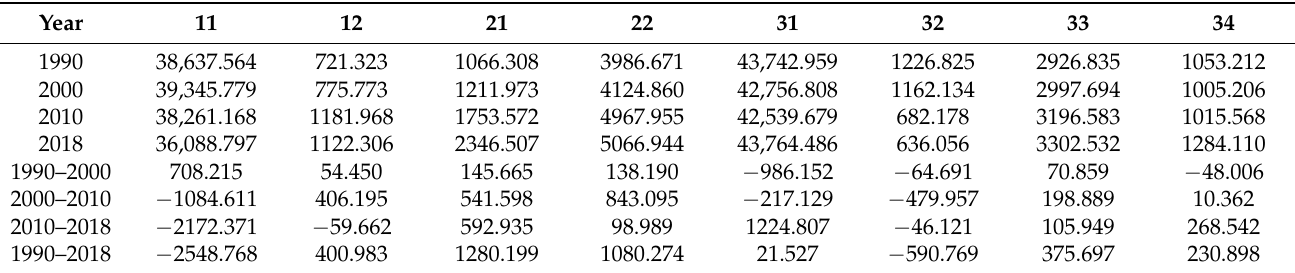
Table 4. Area and changes of land-use types in the central and southern Liaoning urban agglomera- tion 1990–2018 (km 2 ).